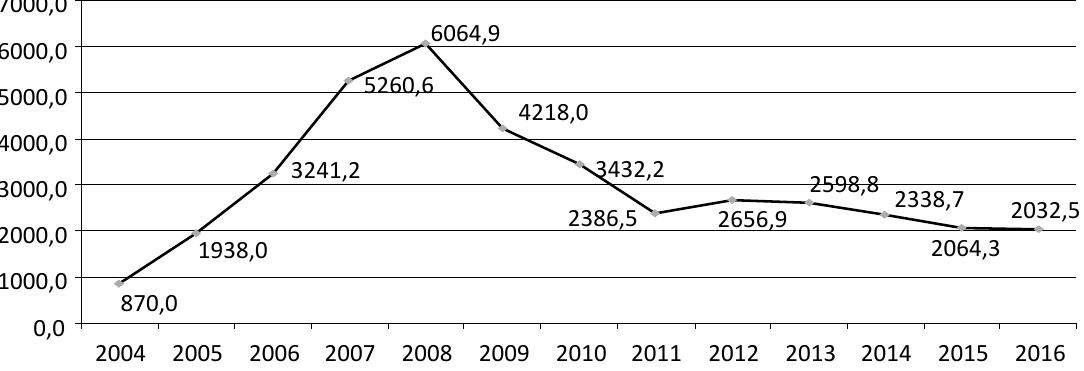
Figure 2. Dynamics of CU’s total assets, 2004−2016 (at the end of the period), million